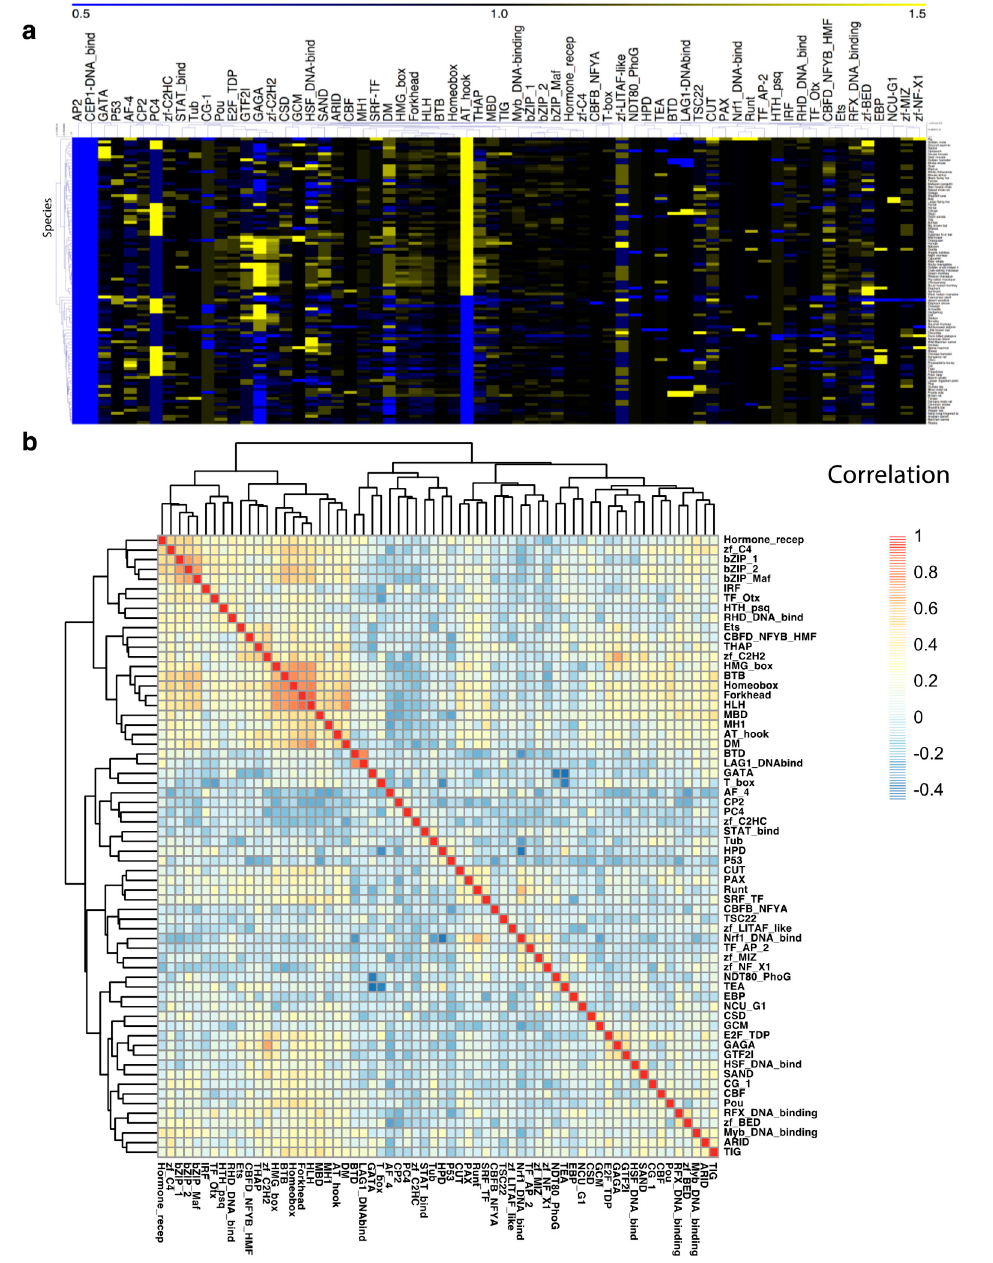
Figure 1. Variation in the number of transcription factors (TFs) within and among TF families. The dendrograms show the hierarchical relationships. ( a ) Variation in the number of TFs within each TF family. X-axis: TF family; y-axis: mammalian species. The average number of TFs in each TF family was standardized to 1 (black). The colors on the heat map represent the degree of TF number variation, where blue is low and yellow is high. ( b ) Correlation of TF number variation among TF families. The colors on the heat map represent the degree of correlation (blue, low; red, high).